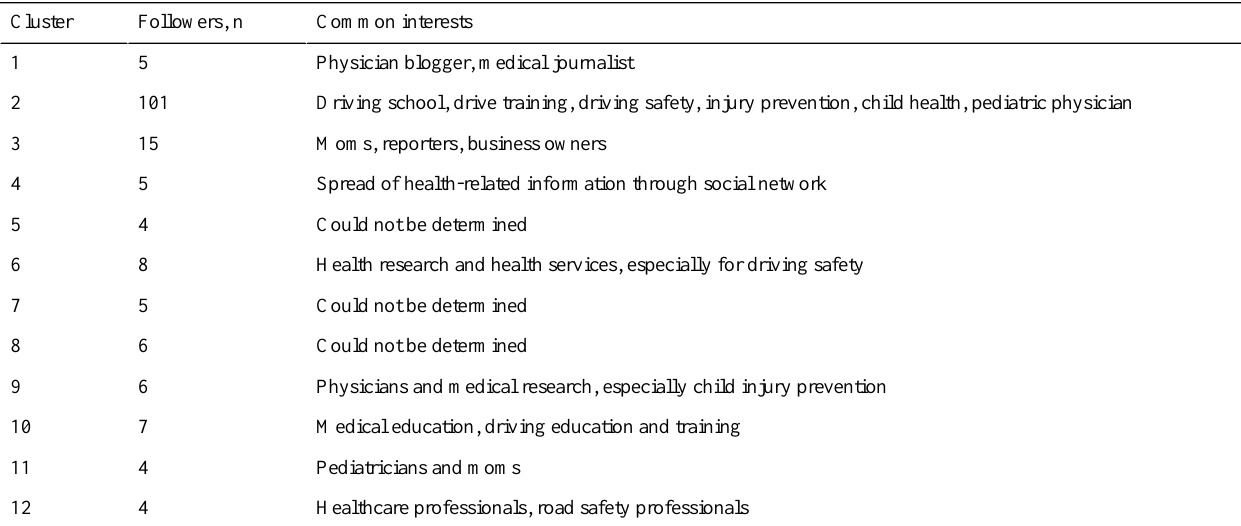
Table 2. Distribution of common interests across the 170 @SafetyMD followers grouped into 12 clusters.